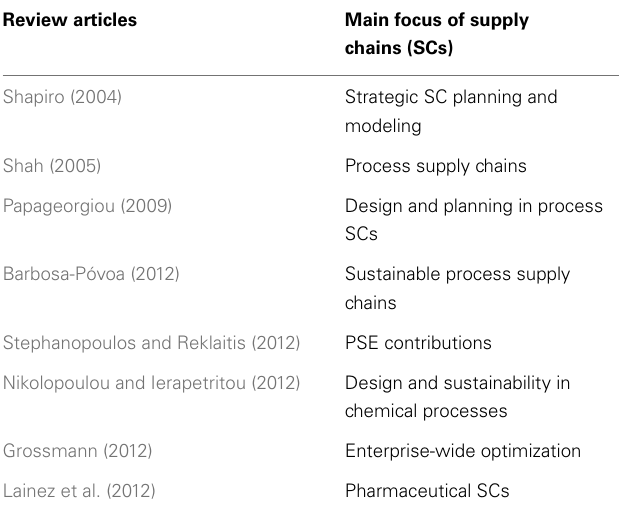
Table 1 | Reviews addressing important process supply chains issues .